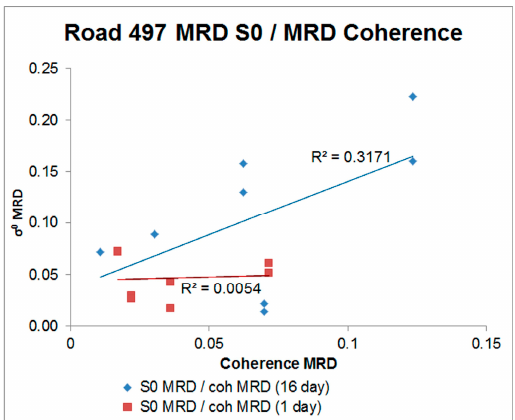
Figure 42. Graph showing clarity of σ 0 residue of Road 497, plotted against clarity of 16-day (blue) and 1-day (red) coherence residues of the same feature. Linear trend lines and R 2 values are shown in blue for the 16-day coherence/ σ 0 plot, and red for the 1-day coherence/ σ 0 plot. A better correlation can be seen for the 16-day coherence/ σ 0 plot.